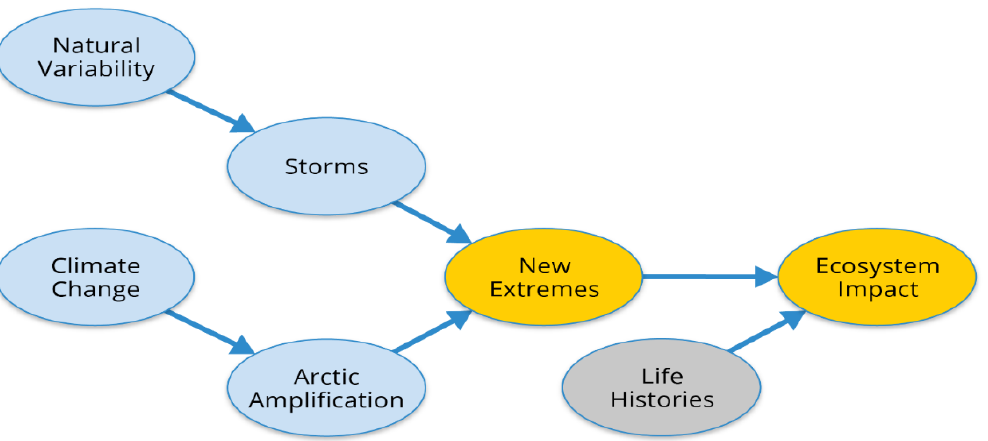
Figure 4. Conceptual model of extremes forced by atmosphere and ocean processes that interact with the ecosystem life histories. the ecosystem life